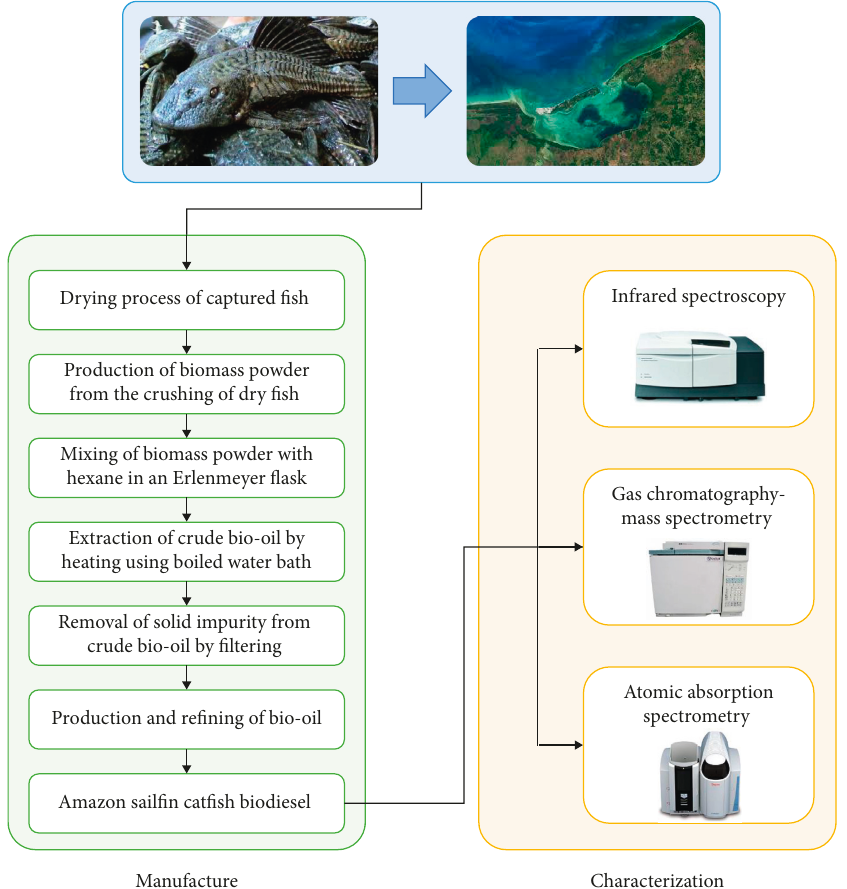
Figure 2: Diagram to obtain the biodiesel and the characterization techniques used in this